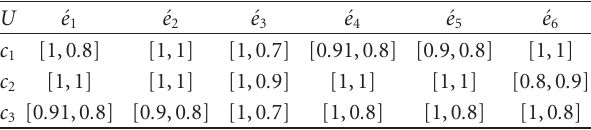
Table 6: Representation of false membership.